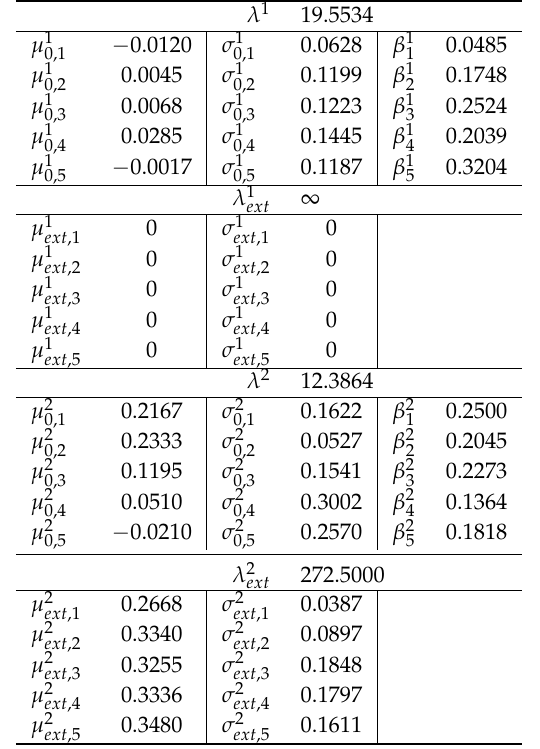
Table 6. ICE U.K. Natural Gas Futures: parameters of the thinned-out Poisson